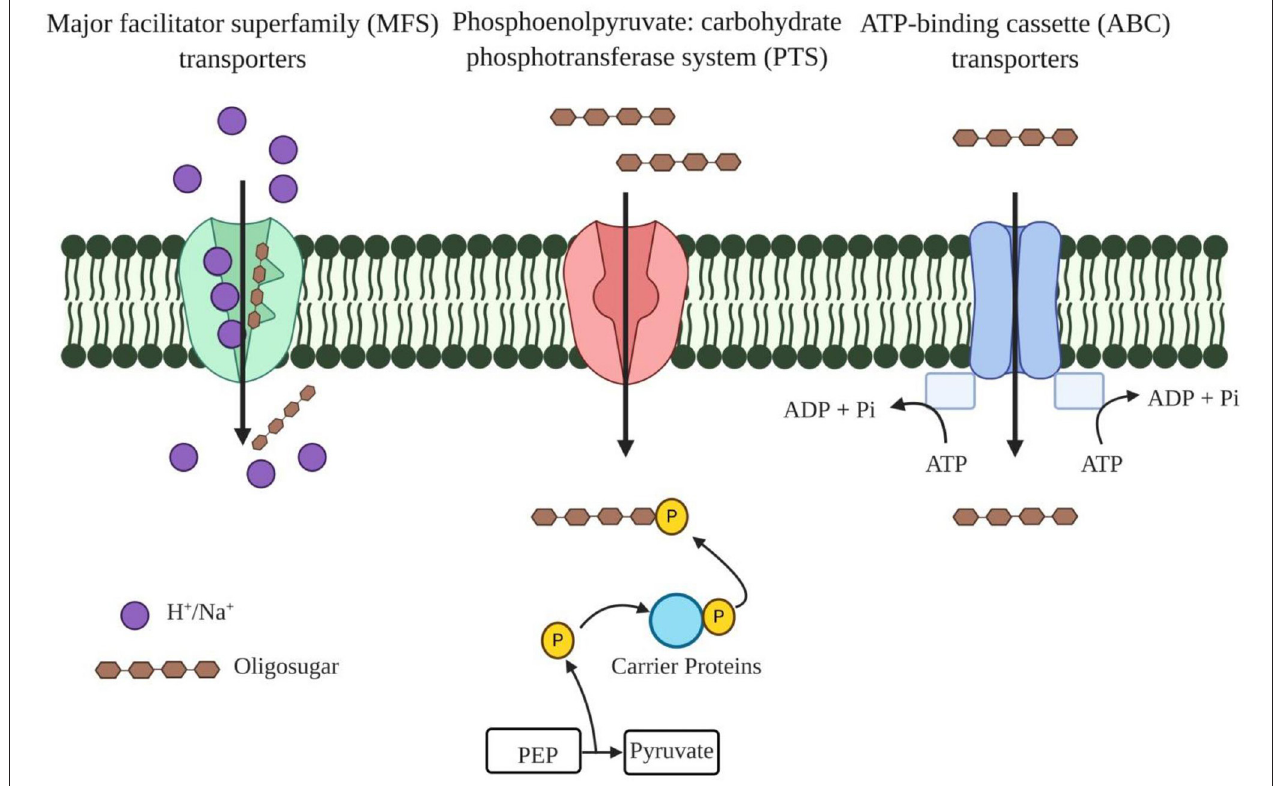
FIGURE 2 | Different oligosaccharide transporters present in the plasma membrane of bacteria. Major facilitator superfamily (MFS) transporters function as a symporter that transport oligosaccharide alongside with Na + /H + as a proton motive factor. Phosphoenolpyruvate (PEP): carbohydrate phosphotransferase system (PTS) transports the oligosaccharide and transported oligosaccharides are further phosphorylated to diffuse back from the cell. ATP binding cassette transporters (ABC) have nucleotide binding domains (NBDs) as these power the transport of substrates across cell membranes by ATP-binding and